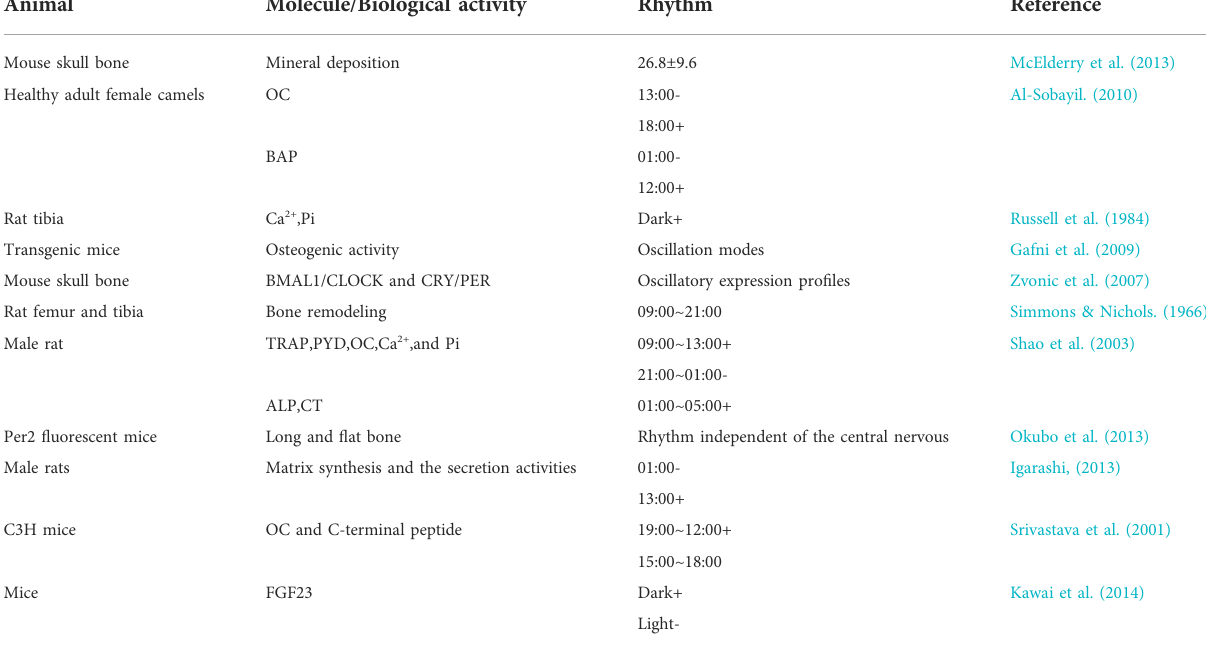
TABLE 2 Animal bone remodeling markers are rhythmic in nature.